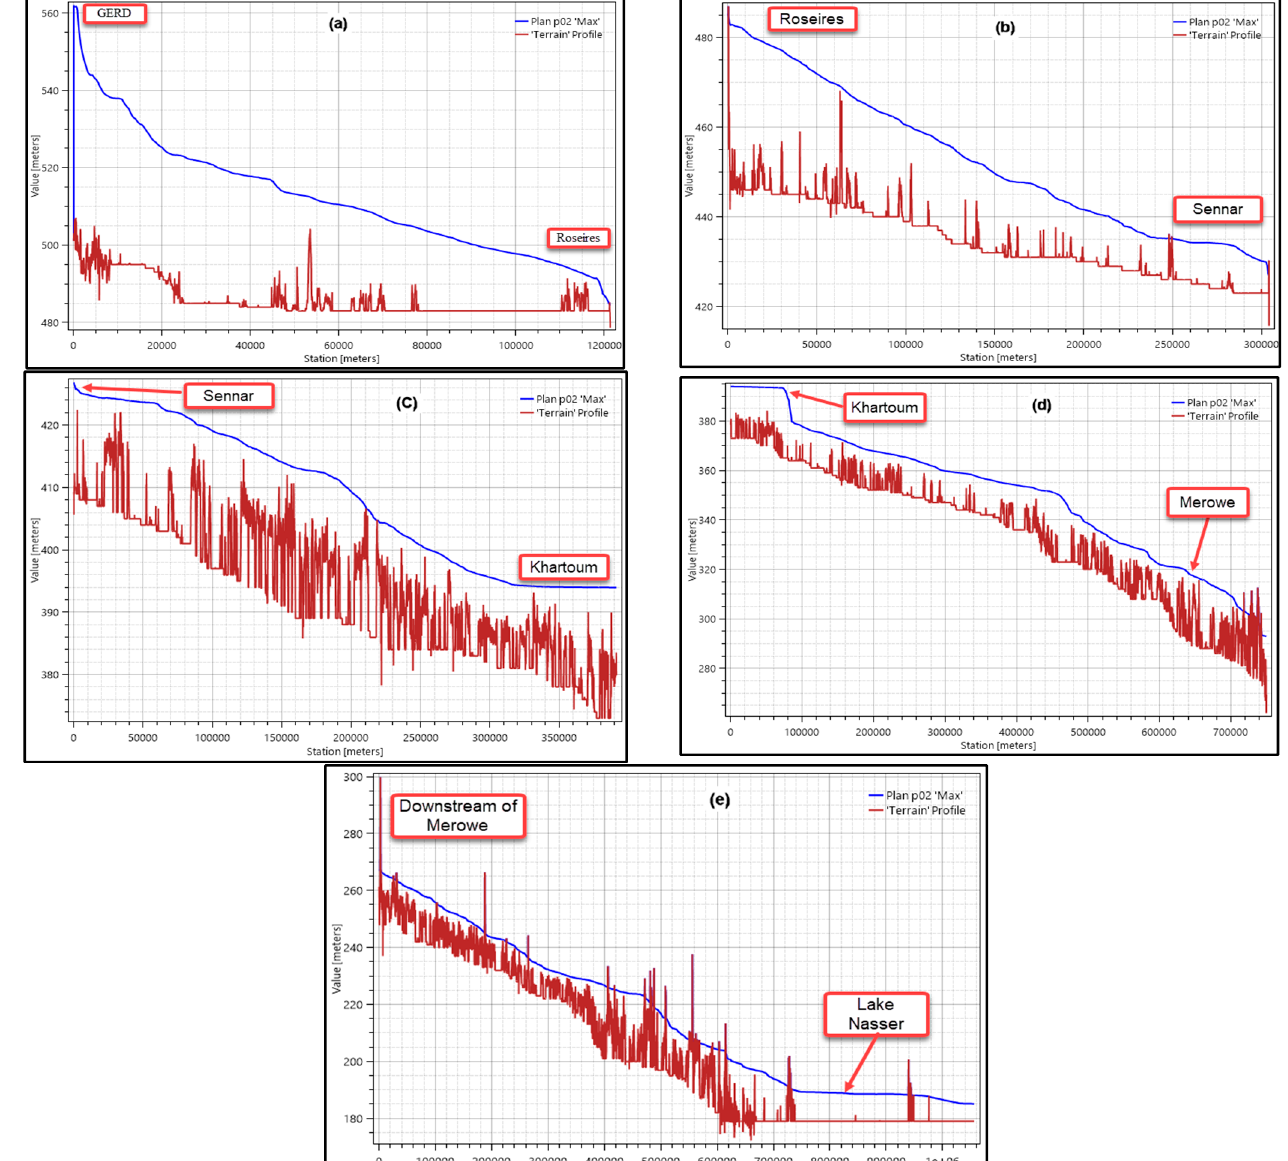
Figure 7. Water surface profile: ( a ) from GERD to Roseires dam; ( b ) from Roseires dam to Sennar dam; ( c ) from Sennar dam to Khartoum; ( d ) from Khartoum to Merowe dam and ( e ) from Merowe dam to HAD.